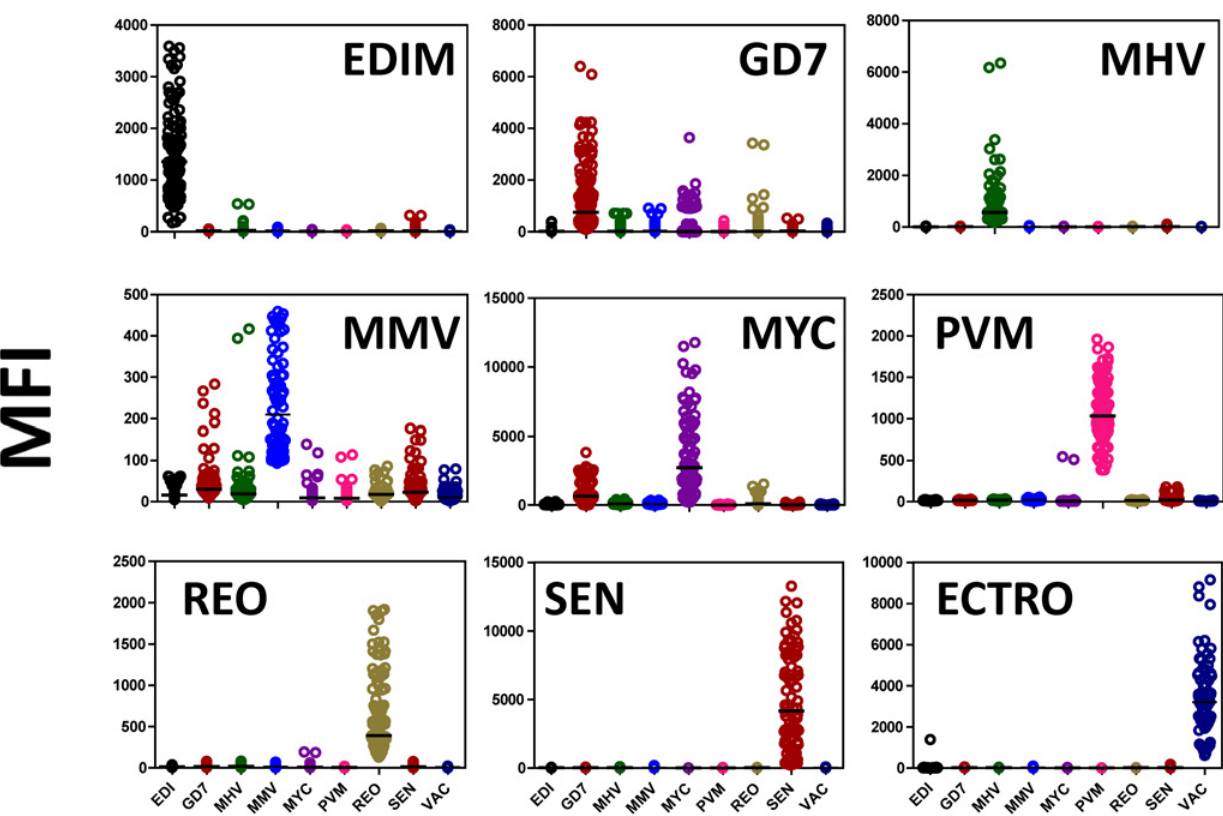
Figure 2. Distribution of median fluorescent intensities (MFI) within the training data for all the nine viruses. Each panel identifies the simultaneous detection of all the nine viruses with the highest value representing the mice that are positive for particular virus that is identified on the top. The abbreviations of the viruses are as follows: Epizootic diarrhea virus of infant mice (EDIM), Theiler ’ s mouse encephalomyelitis virus/GDVII strain (GD7), Mouse hepatitis virus (MHV), mouse minute virus (MMV), Mycoplasma pulmonis (MYC), Pneumovirus of mouse (PVM), Respiratory enteric orphan virus (Reo-3 virus) (REO), Sendai virus (SEN) and Ectromelia virus